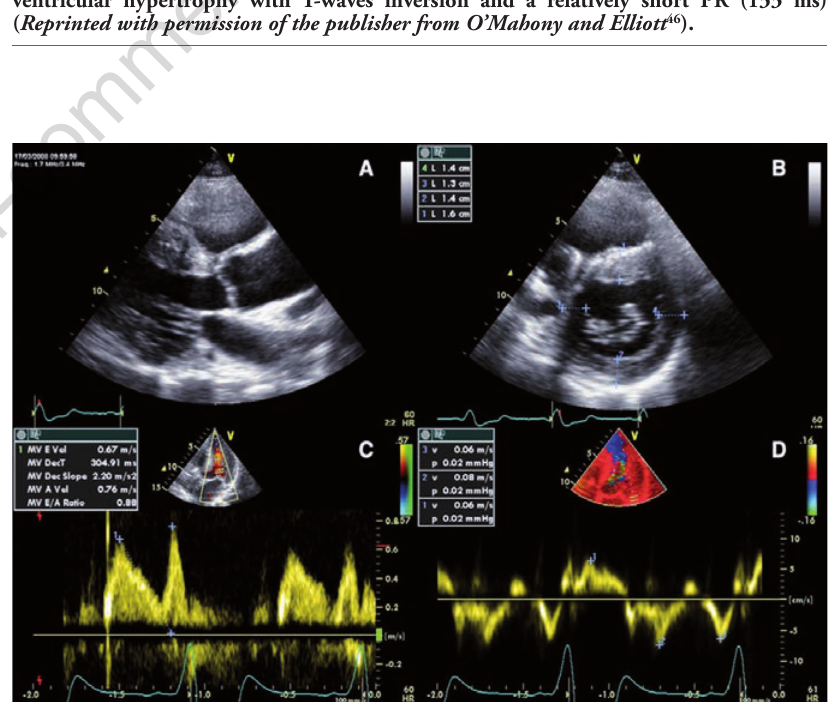
Figure 5. Typical echocardiographic aspect of Anderson-Fabry disease-related cardiomy- opathy. The 2-D images in panel A and B show mild, concentric left ventricular hypertro- phy. There is also mild diastolic dysfunction (panel C and D) ( Reprinted with permission of the publisher from O’Mahony and Elliott 46